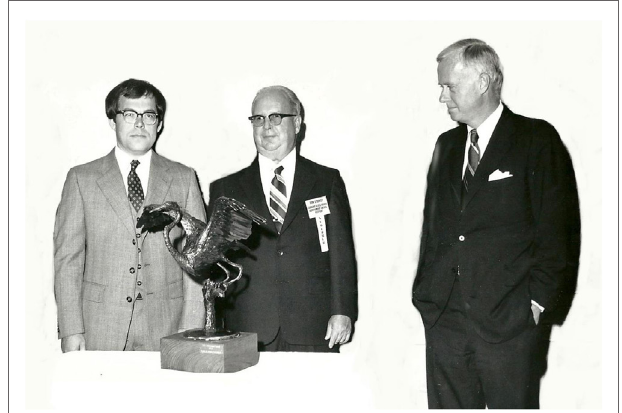
FiGURe 13 | Don Stookey with Phoenix Award (1975) and lifetime friends: technician Joe Pierson (left) and Corning Glass works CeO and future U.S. Congressman Amory Houghton, Jr .